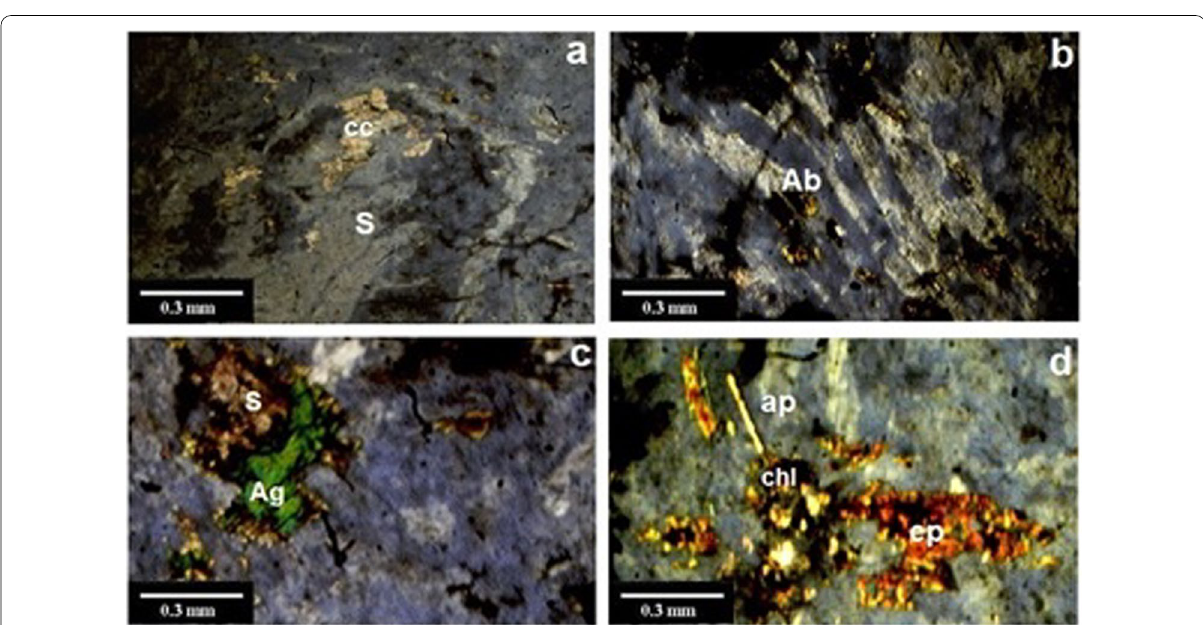
Fig. 2 a Photomicrograph showing sanidine crystal (S) phenocryst altered to calcite (cc). (XPL). b Photomicrograph showing cracked albitephenocryst (Ab) exhibiting minor displacement along minor fault. (XPL). c Photomicrograph showing aegerine (Ag) crystal intruding severely altered sandine crystal (S) in ophetic relation (XPL) d Photomicrograph showing epidote (ep), apatite (ap) and chlorite (chl) overgrown on feldspar crystal. (XPL)